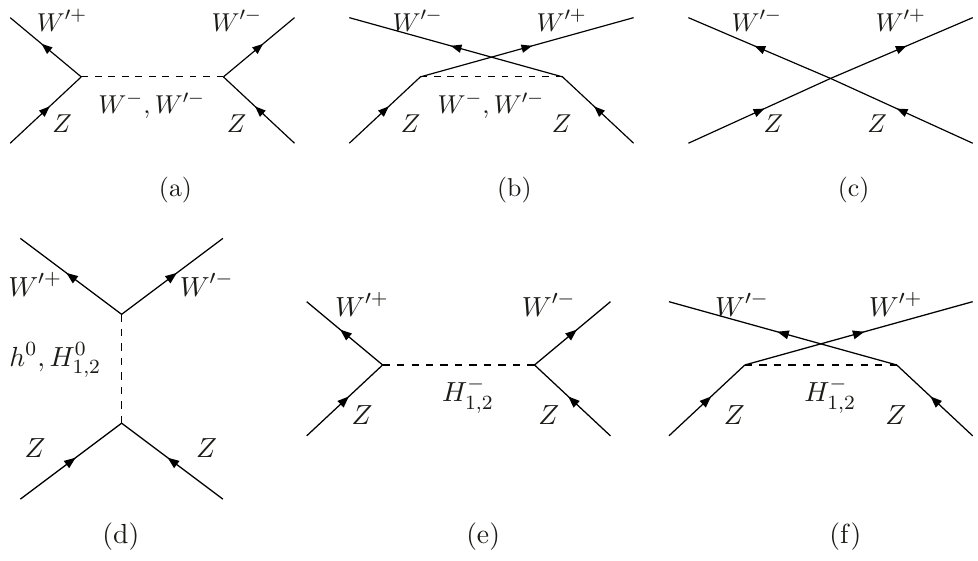
Figure 1 . Diagrams contributing to ZZ ! W 0 W 0 . The other scatterings discussed in the text can be obtained from these diagrams changing the labelling of the lines accordingly. No contact term is present for Z 0 Z 0 ! WW and the (cid:12)rst line is absent when only Z or Z 0 gauge bosons